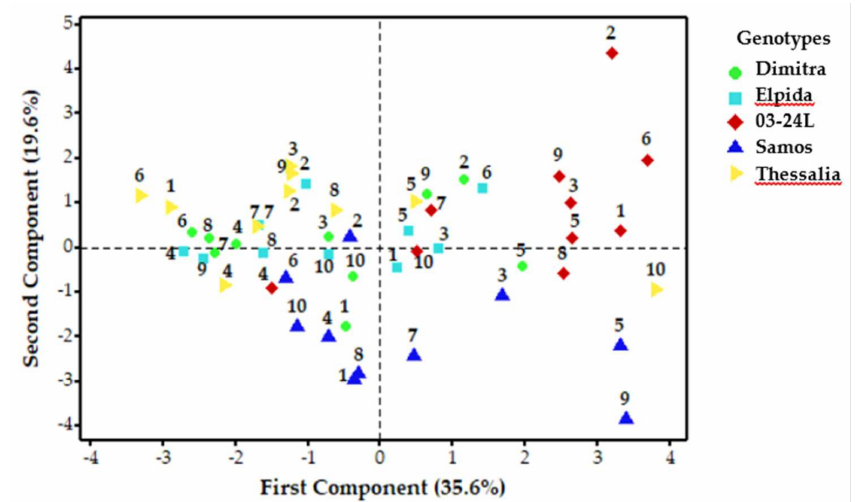
Figure 3. Score plot of lentil genotypes grown under ten different locations in 2019 and 2020 for phytochemical compounds (total phenolic content, total flavonoids content, total proanthocyanidins content, total hydrolyzed tannin content, phenolic acids, flavanols, tocopherols and carotenoids) and antioxidant activity as evaluated by ABTS, DPPH and FRAP methods (N = 150) by location codes (1, Domokos; 2, Larissa; 3, Thessaloniki; 4, Orestiada; 5, Petrana; 6, Ipato; 7, Patriki; 8, Komotini; 9, Ag. Anargiri; 10,